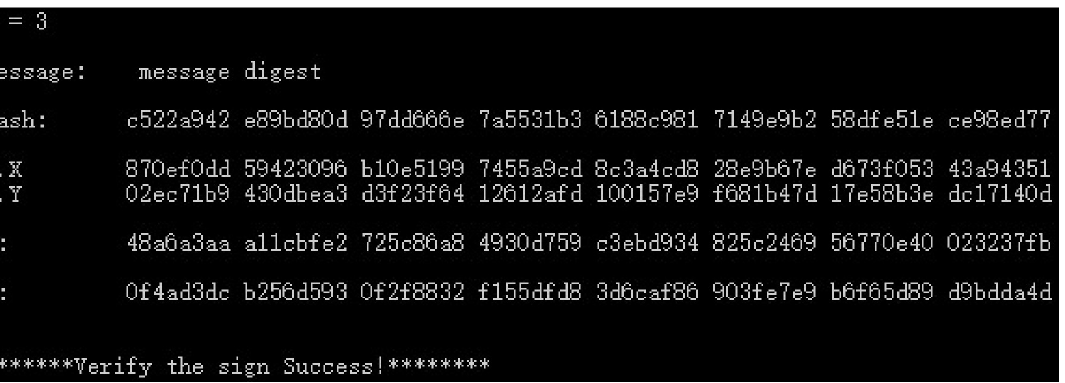
Fig 7. 3-party co-digital signature and verification data.